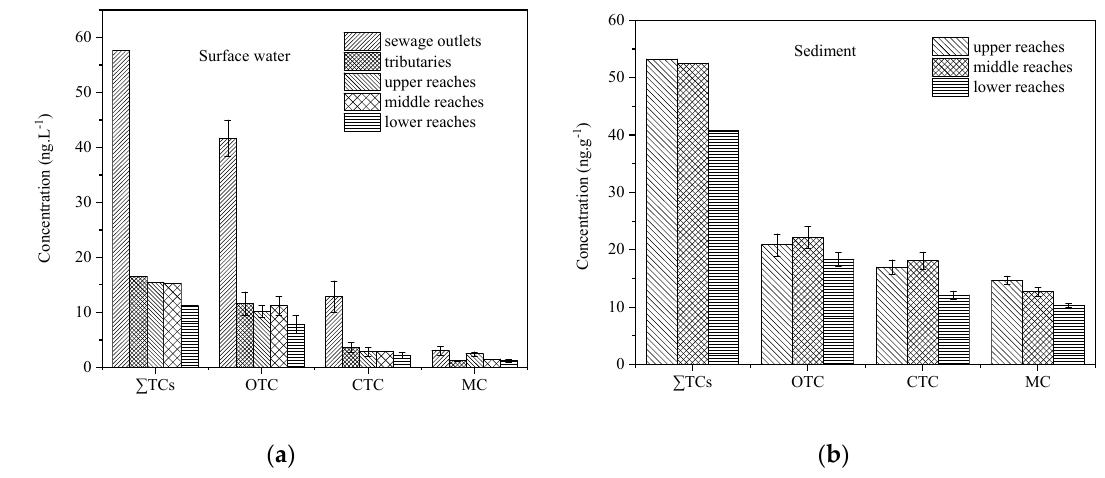
Figure 2. Spatial distribution of TCs in ( a ) surface water and ( b ) sediment from the Weihe River.